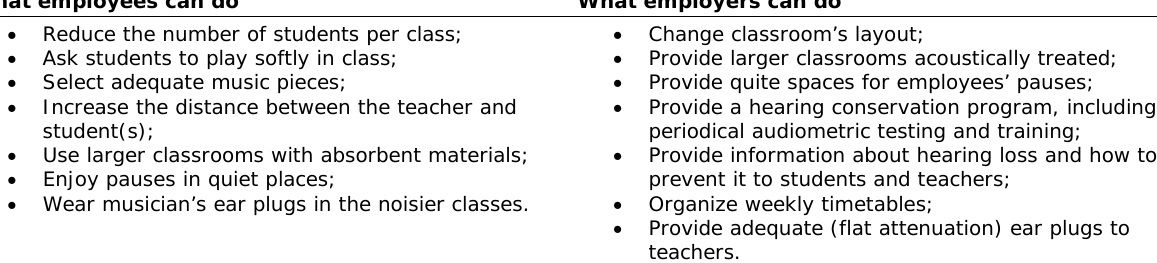
Table 1. Control measures to be implemented for noise reduction and NIHL